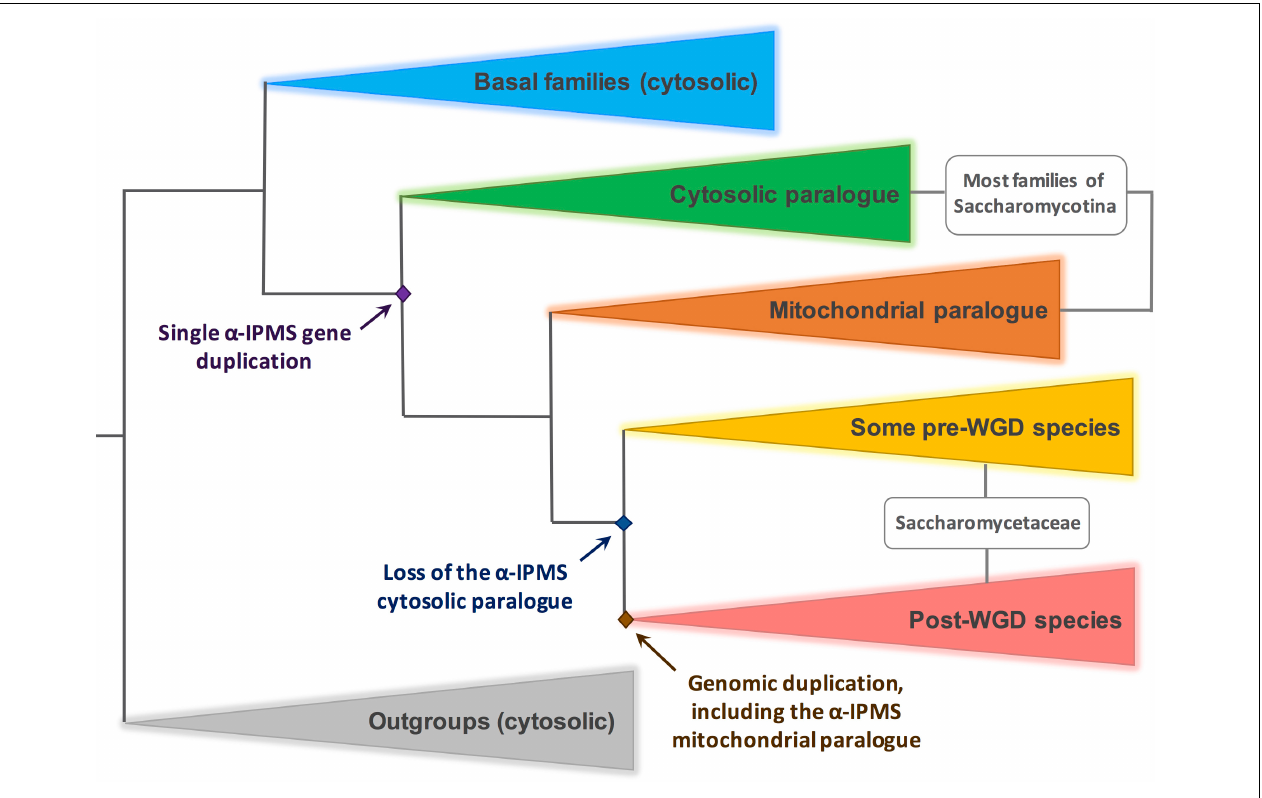
FIGURE 8 | Duplication and loss events of genes encoding α -IPMS in the Saccharomycotina. A simplified scheme, based on the results of a comprehensive phylogeny shown in Supplementary Figure S2 . The outgroup (gray triangle) include α -IPMS genes of representative species of Taphrinomycotina and Pezizomycotina. In these clades only one paralog is extant, presumably cytosolic (see text and Supplementary Data Sheet 1 ). The blue triangle includes basal species of Saccharomycotina where no α -IPMS gene duplication has occurred. Within the Saccharomycotina, a gene duplication occurred (green and brown triangles), leading to the genomes of most species comprising two isoforms, presumably cytosolic and mitochondrial respectively. KlLEU4BIS and KlLEU4 are included in the green and brown clade respectively. In several pre-WGD members of the Saccharomycetacea (represented by a yellow triangle), including those giving origin to the WGD, the cytosolic paralog was lost. Thus, the WGD results in two mitochondrial isoforms (red triangle). ScLEU4 and ScLEU9 originate from this